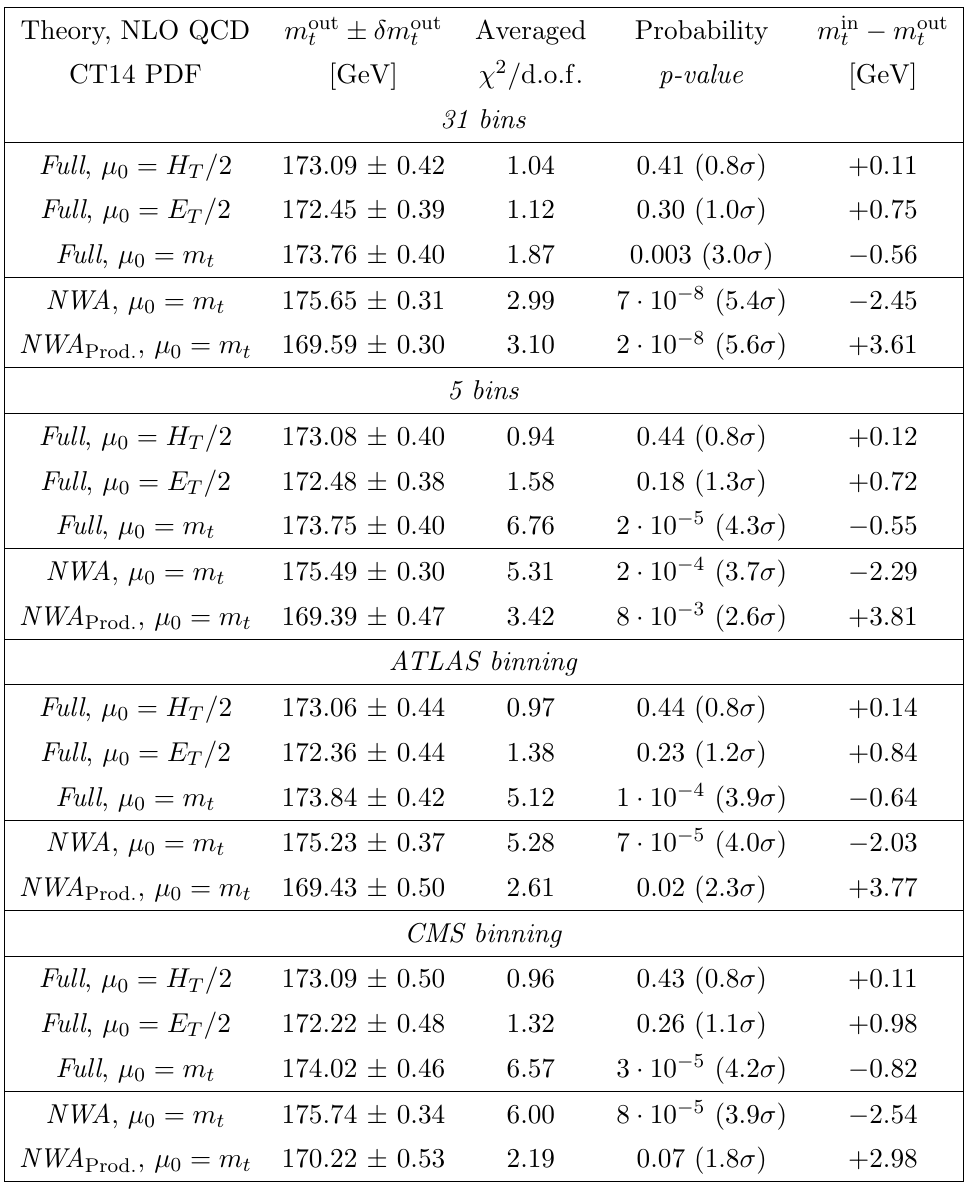
Table 5 . Mean value of the top quark mass, m out , from 1000 pseudo-experiments as obtained from t the normalised (cid:26) s di(cid:11)erential distribution for the pp e + (cid:23) e (cid:22) (cid:0) (cid:22) (cid:23) (cid:22) b (cid:22) bj + X production process at ! the LHC with p s = 13 TeV. Also shown is 68 % C.L. (1 (cid:27) ) statistical error of the top quark mass, (cid:14)m out , together with the averaged minimal (cid:31) 2 =d:o:f and the p-value. The number of standard t deviations corresponding to each p-value is presented in parentheses. In the last column the top quark mass shift, de(cid:12)ned as m in m out , with m in = 173.2 GeV, is also given. Luminosity of 25 fb (cid:0) 1 t (cid:0) t t is assumed.